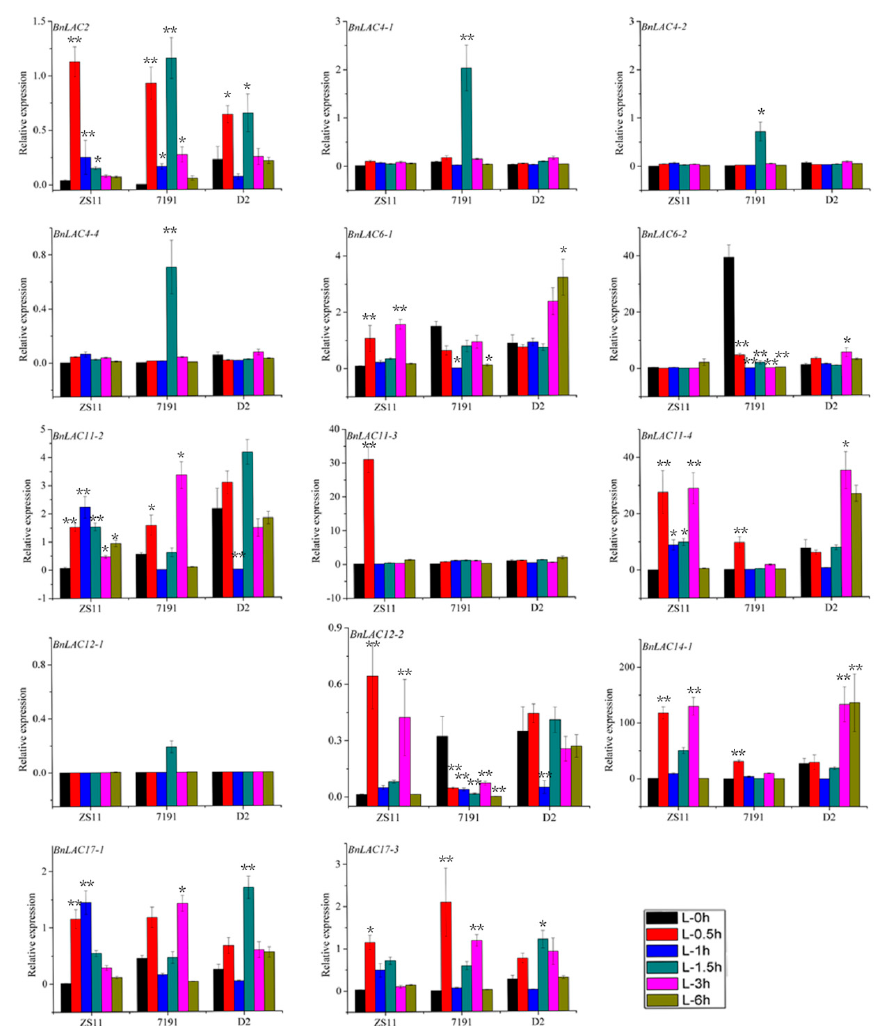
Figure 10. Quantitative RT-PCR of 14 BnLACs in B. napus leaves in response to wounding stress. Expression of Actin and UBC21 were used to normalize the expression level of each LAC gene at each time point. Bars represent means ± SEM of three biological replicates. Bars marked with asterisks indicate significant di ff erences (Student’s t-test) to corresponding control samples for the same time point, * P < 0.05, ** P < 0.01. The results were presented by OriginPro 8. Di ff erent color means di ff erent time after wound shown as bar at lower right corner.